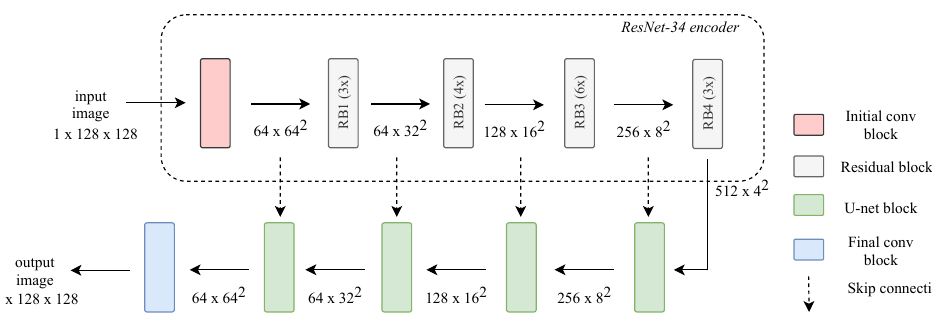
Figure 1. Hybrid structure that results from combining the ResNet-34 and U-Net